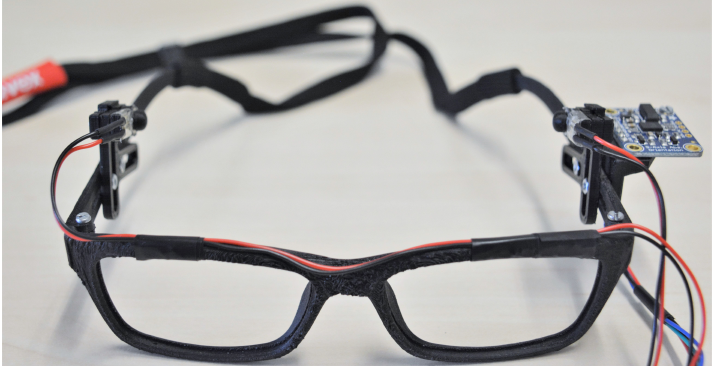
Figure 3. Image of the mouse alternative. The inertial measurement unit that tracks head motions for mouse cursor control is shown on the right. Force-sensing resistors are mounted onto each temple and can be adjusted in position to ensure good contact with the Temporalis muscle for mouse click activation. The spectacle strap is used to avoid involuntary movement of the spectacles caused by head motions or the activation of the Temporalis muscle.